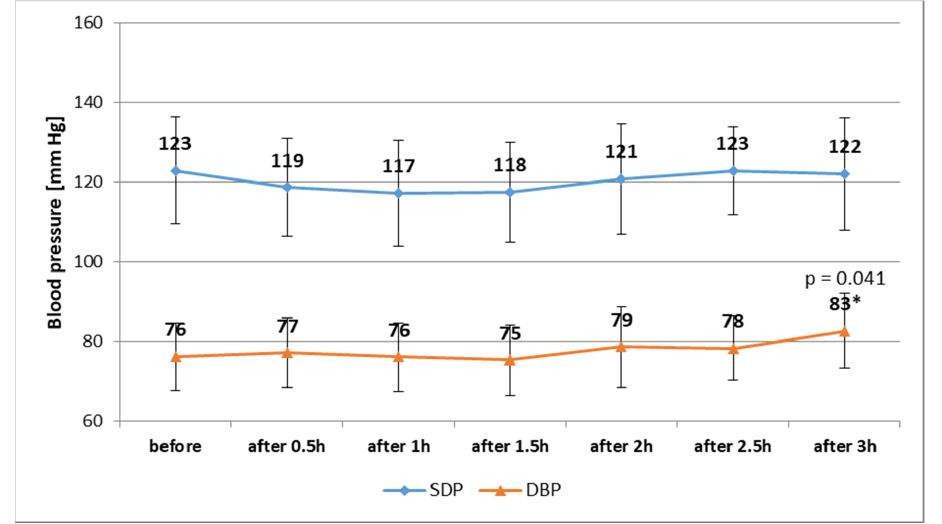
Figure 1. Changes in SBP and DBP of participants—ED group. Data are mean ± SD ( n = 36); * Statistical significance (at p < 0.05) was only stated between 2.5 and 3 h; SBP—systolic blood pressure; DBP—diastolic blood pressure. Table 3. Blood pressure (SBP, DBP), heart rate (HR) and blood glucose (BG) of participants. Parameter ED Group ( n = 36)